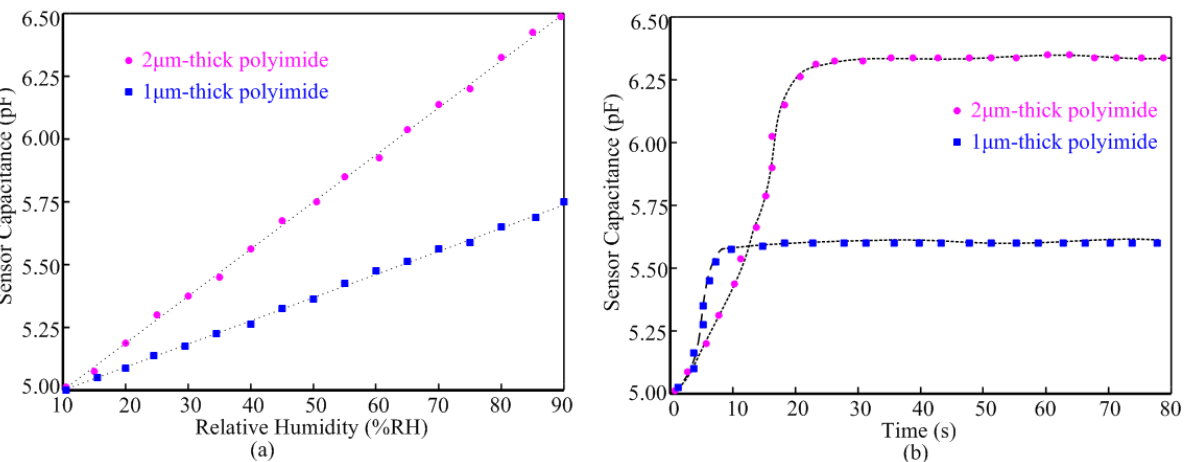
Figure 6. Performance comparison of the sensors with different polyimide layers at 25 ° C; ( a ) sensitivity comparison; ( b ) response time